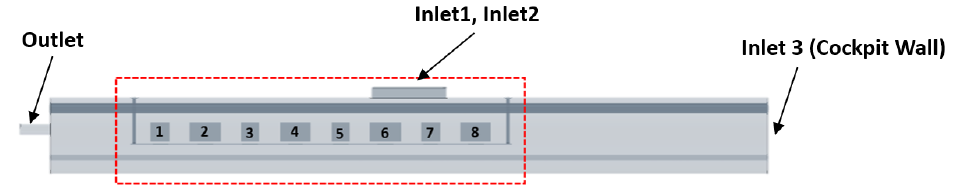
Figure 11. Side view of the underfloor equipment bay (Configuration 2).